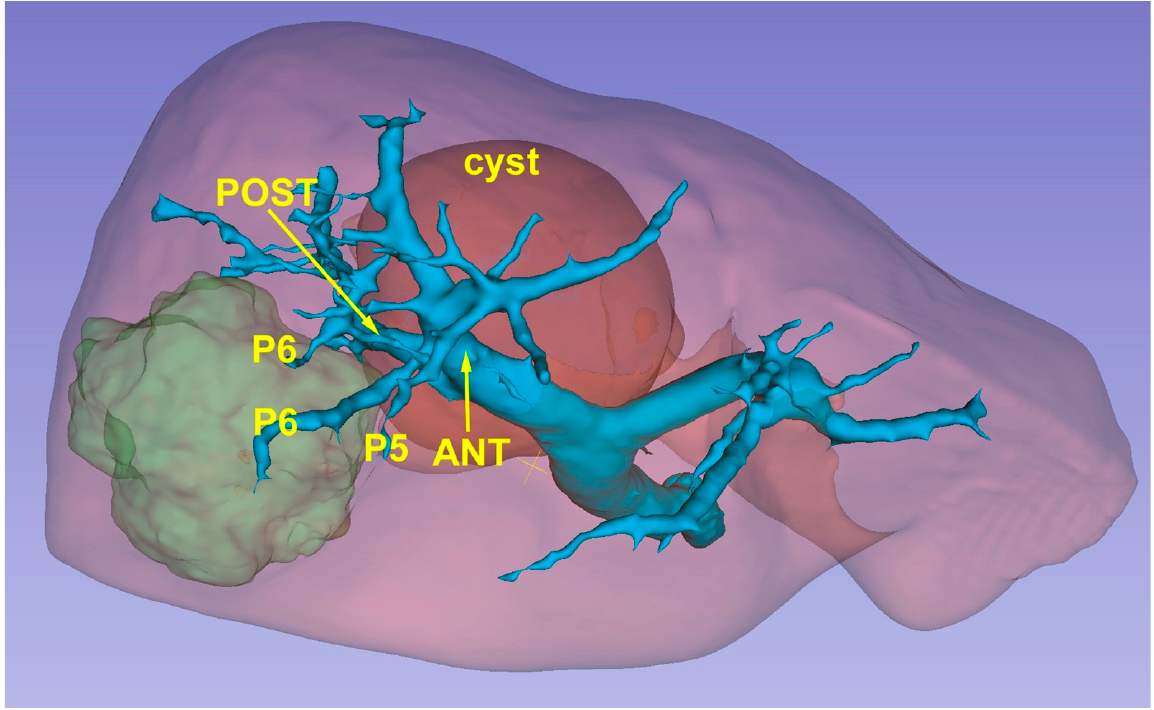
Figure 3. A 3D reconstruction which permits the identi fi cation of the lesion(cid:31)s position (green) in relationship with glissonean pedicles. relationship with glissonean